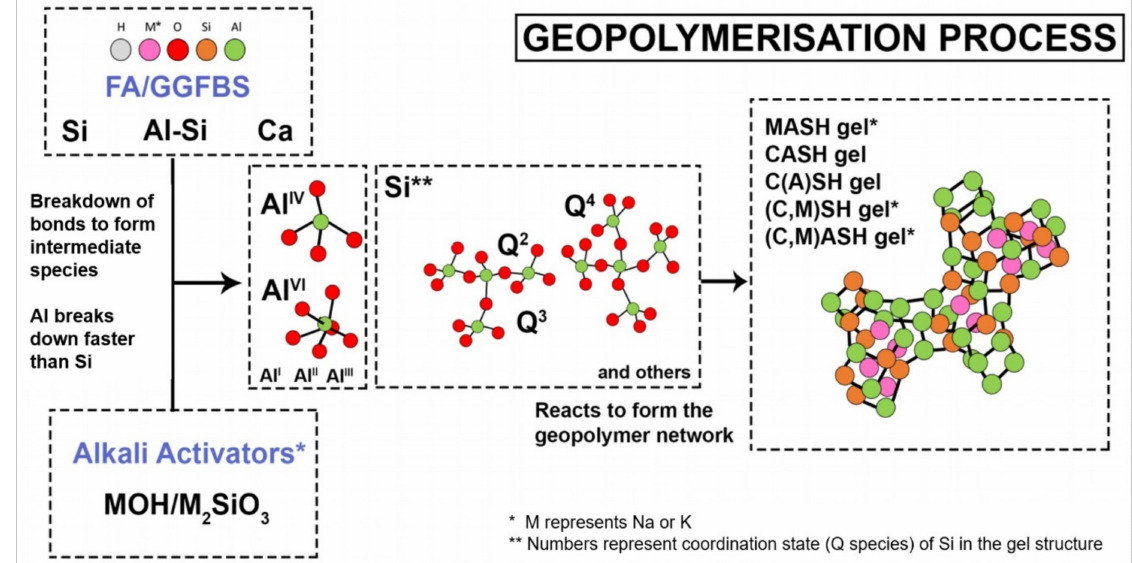
Figure 3. A chemical view of the geopolymerization reaction mechanism of aluminosilicate (breakdown of bonds and formation of intermediate species) dissolution in the activator solution. Reprinted with permission from Ref. [22]. Copyright 2021, with permission from MDPI.